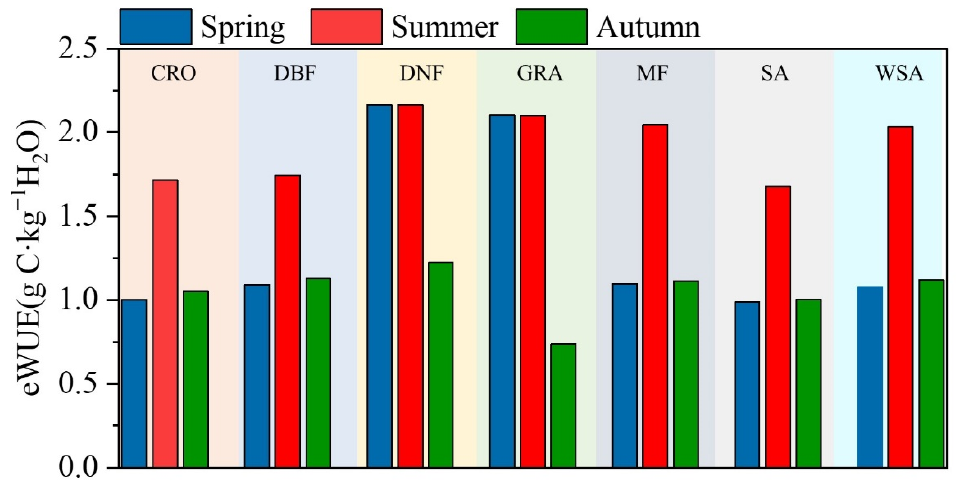
Figure 7. eWUE statistics for different vegetation types in spring, summer and autumn in Inner Mongolia.